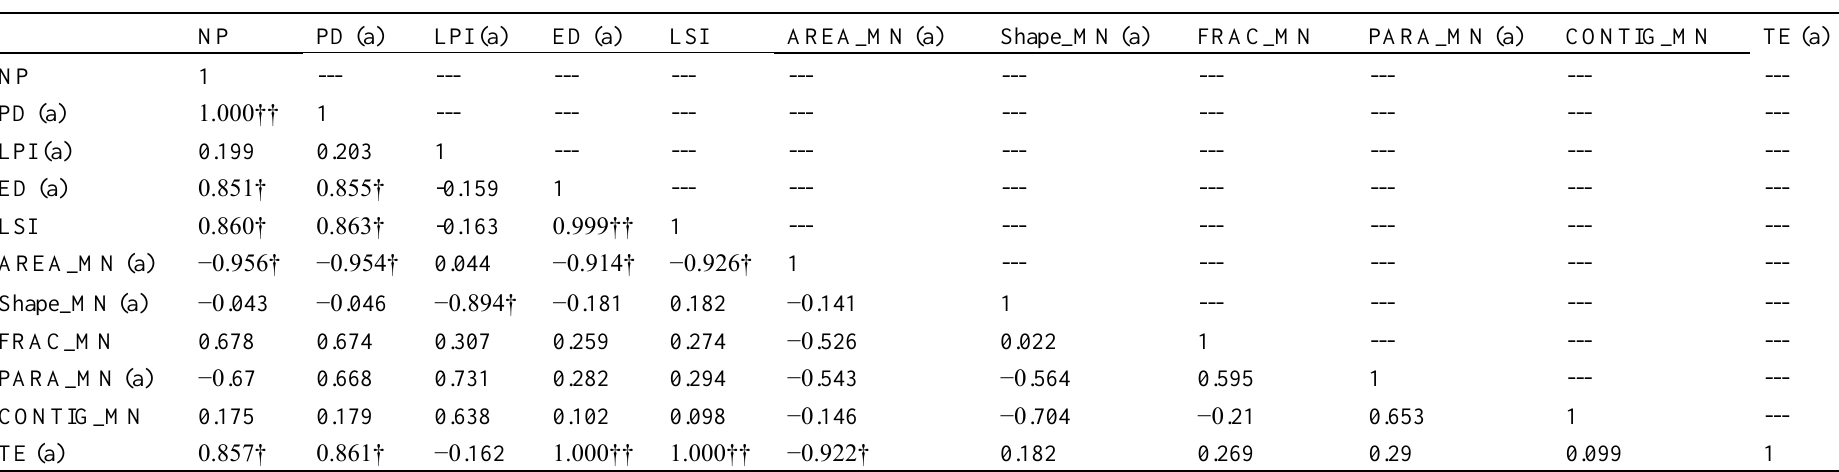
Table 1. Pearson’s correlation matrix for fragmentation metrics used in the Arkansas bat fragmentation study,